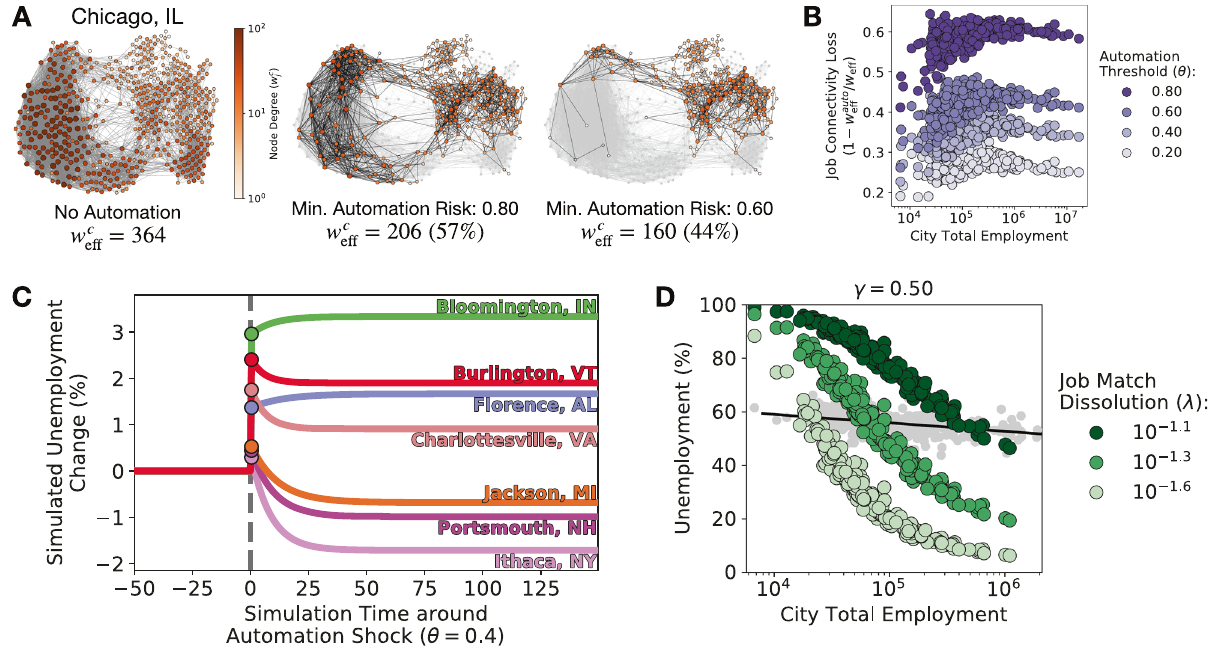
Fig. 4 Automation decreases job connectivity in cities and yields diverse employment responses. A The job network projection of Chicago, IL in 2014 ¼ 307). Job connectivity ( w c ( w c ) decreases as occupations are removed from the labor market according to each occupation ’ s automation risk 4 . B The eff eff change in job connectivity across cities of different sizes with varying automation exposure. w auto denotes the city ’ s job connectivity after removing off occupations from automation. C Simulated city responses to an unemployment shock from automation. If occupation i has probability of automation greater than θ = 0.4, then all workers of i immediately become unemployed and we set w c ij ¼ 0 for each other occupation j . Each simulation begins